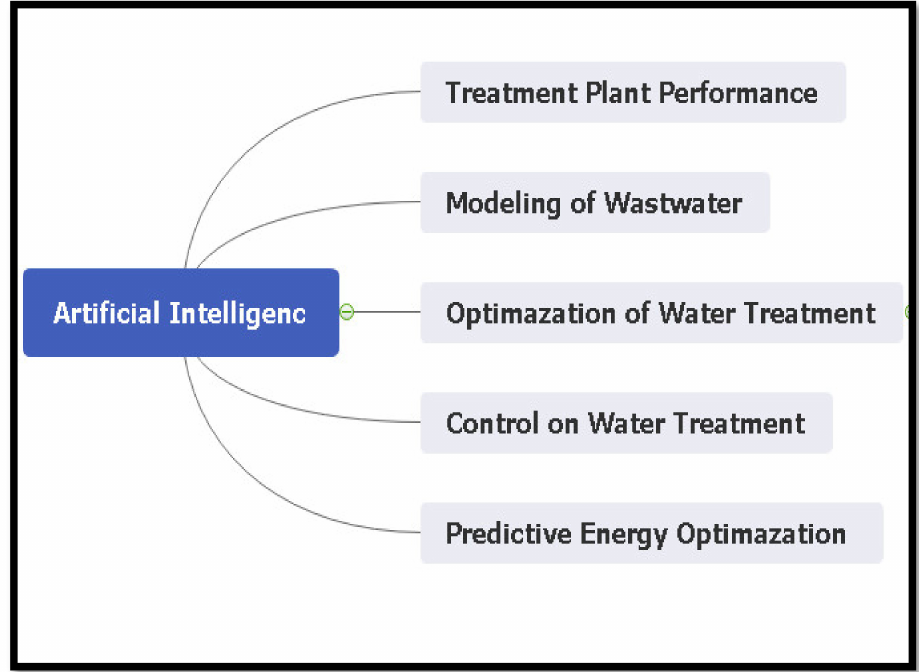
Figure 16. Applications of artificial intelligence in wastewater